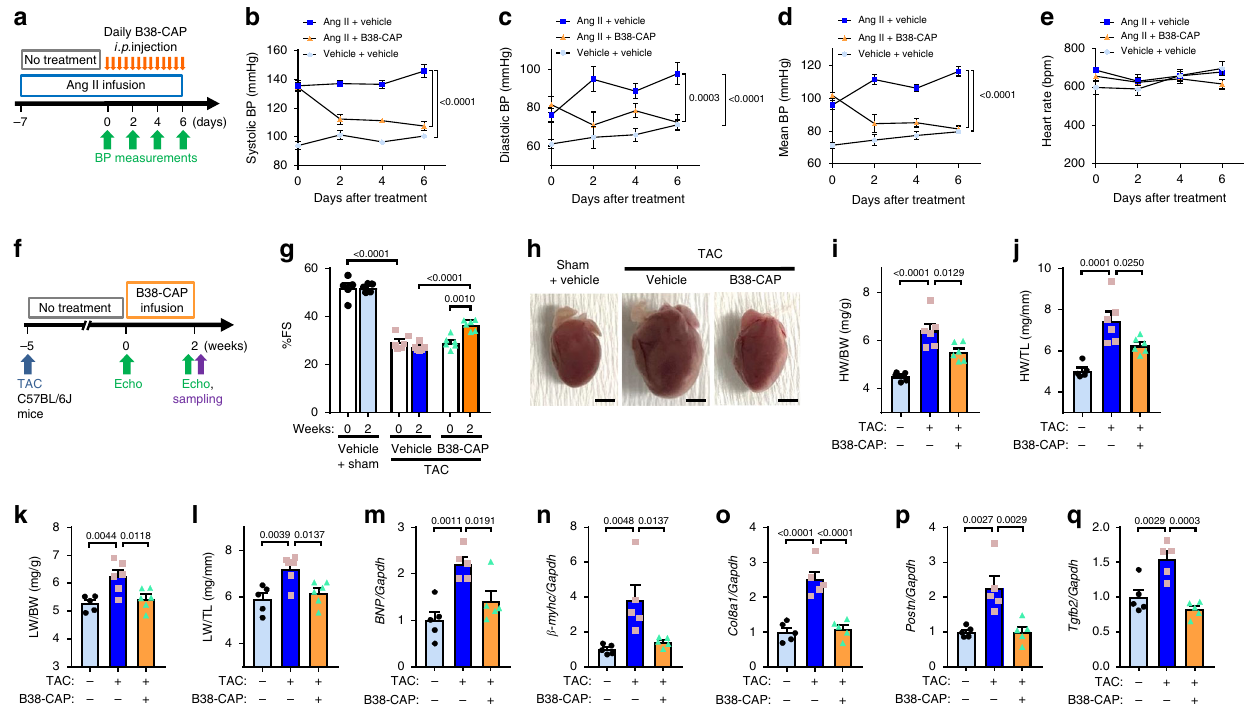
Fig. 7 Therapeutic effects of B38-CAP on established hypertension and cardiac dysfunction. a – e Therapeutic effects of B38-CAP on established